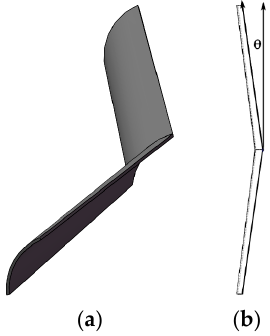
Figure 2. Definition of inclination angle of the blade: ( a ) the 3D model; ( b ) definition of the inclination